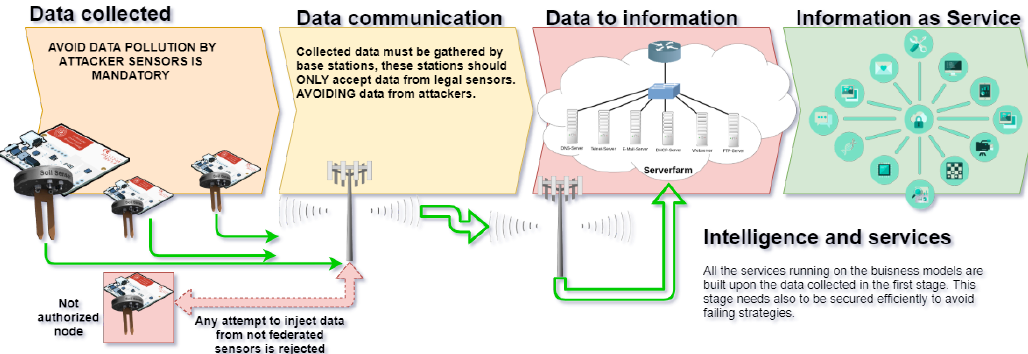
Figure 1. Stages from collecting data to processing information: the importance of securing the